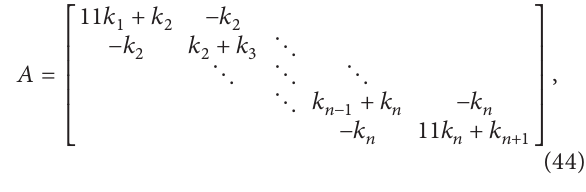
Figure 1: Numerical results of Example 5 with PCM and GGL methods.